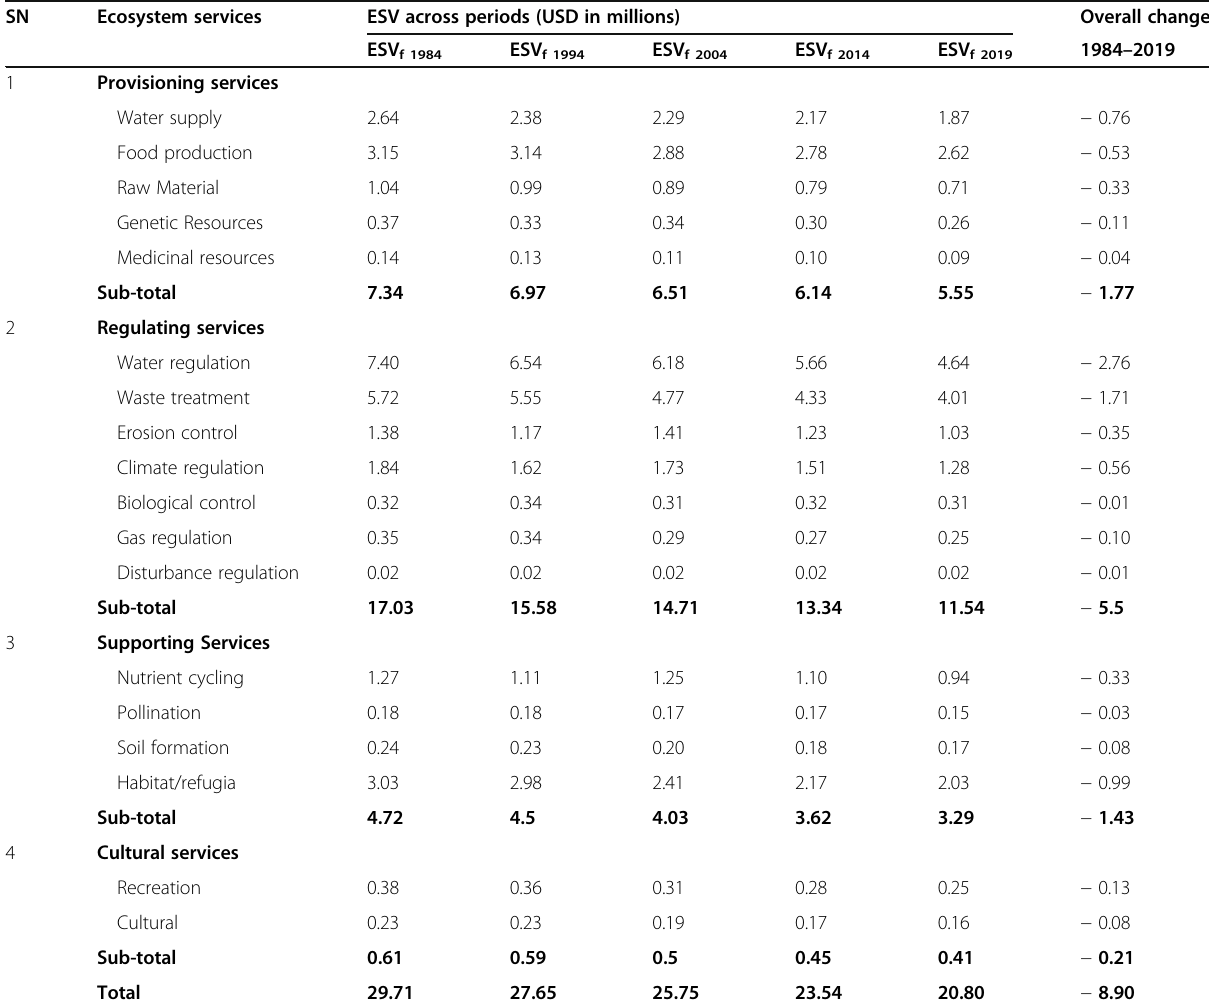
Table 9 The impacts of land use/land cover changes on the individual ecosystem service values (ESV) of Bahir Dar City between 1984 and 2019 SN Ecosystem services ESV across periods (USD in millions)